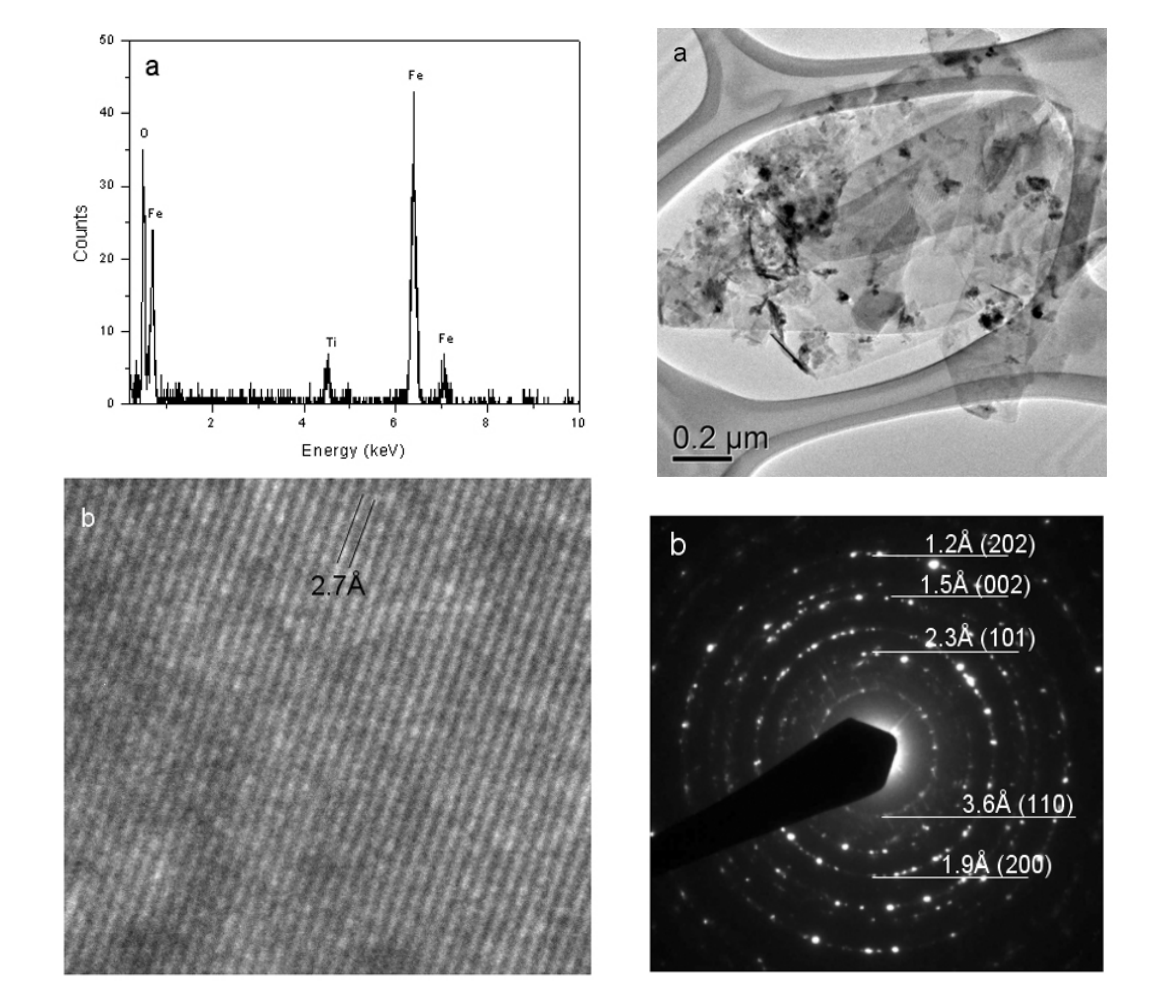
H Ti Fe O •nH O nanosheets x-y y 2-x x 4 2